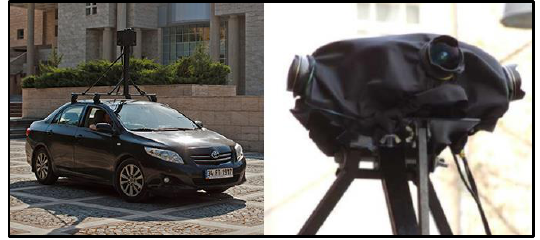
Figure 14. Devices used by Yandex Maps for panorama images.